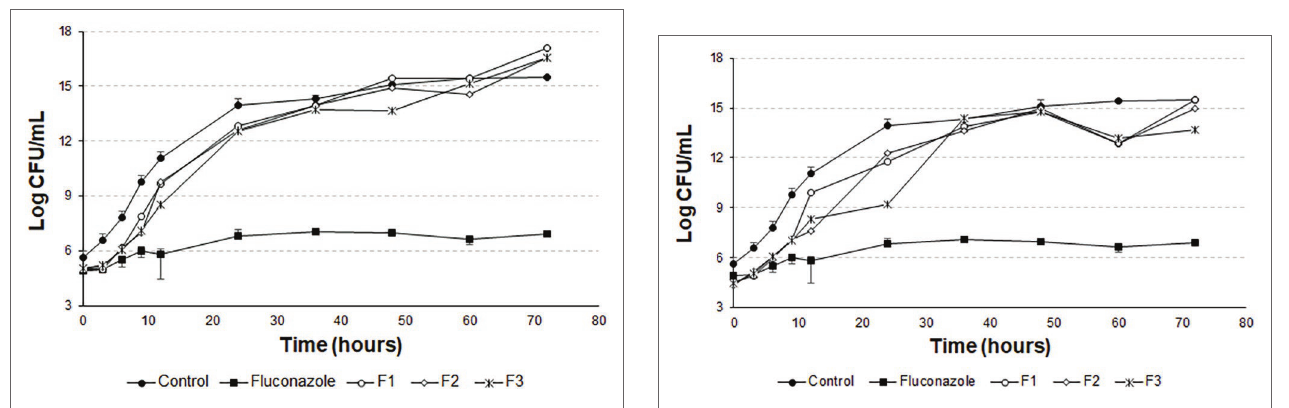
FIGURE 7 | Time-kill curves for C. albicans (ATCC 90028) treated with sonicated and empty F1, F2, and